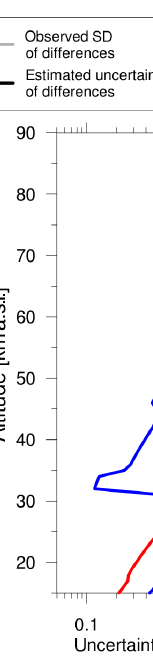
Figure 18. Similar to Figs. 10–13 but for temperature. The es- timated measurement uncertainty for temperature measured by LiO 3 S (red curve) and NASA STROZ (blue curve), estimated com- bined uncertainty for temperature differences between the two sys- tems (black curve), and observed standard deviation of tempera- ture differences between the two systems (grey curve) during LA- VANDE are